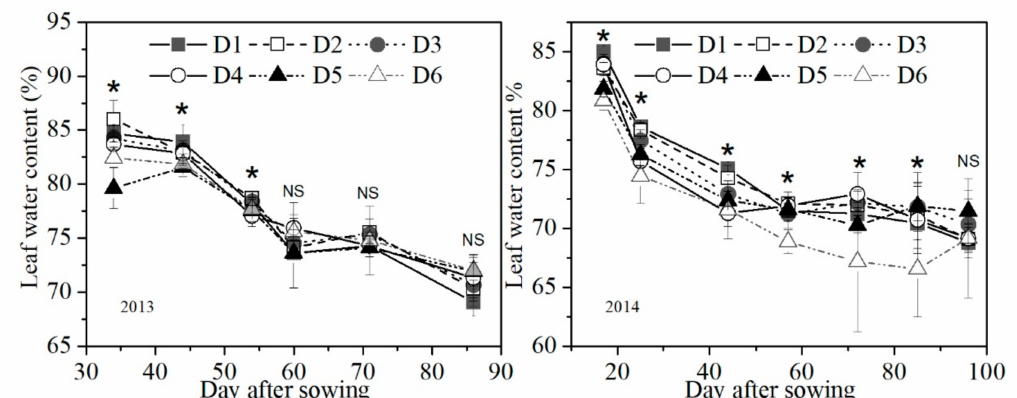
Figure 1. Leaf water content (LWC) changes with the development process of drought during 2013 and 2014. Note: *, significant differences at the 5% level were found in various treatments; NS, significant differences at the 5% level were not found in various